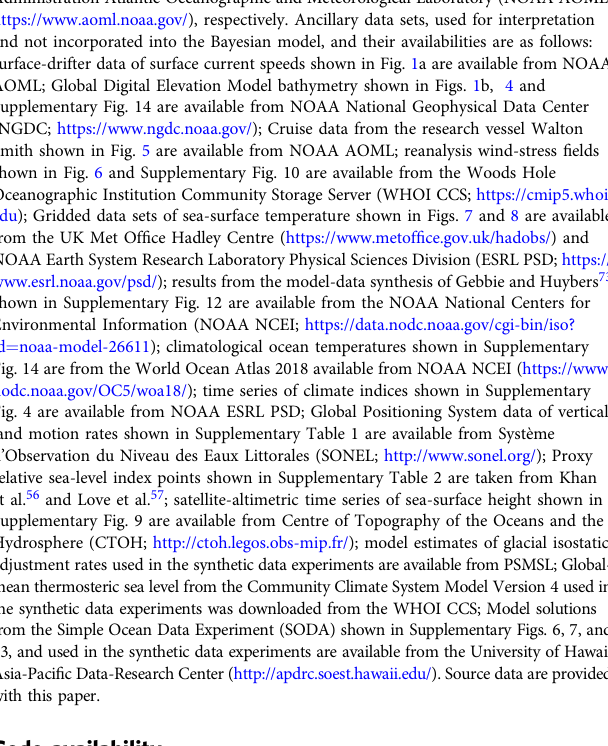
Supplementary Fig. 9 are available from Centre of Topography of the Oceans and the Hydrosphere (CTOH; http://ctoh.legos.obs-mip.fr/); model estimates of glacial isostatic adjustment rates used in the synthetic data experiments are available from PSMSL; Global- mean thermosteric sea level from the Community Climate System Model Version 4 used in the synthetic data experiments was downloaded from the WHOI CCS; Model solutions from the Simple Ocean Data Experiment (SODA) shown in Supplementary Figs. 6, 7, and 23, and used in the synthetic data experiments are available from the University of Hawaii Asia-Paci fi c Data-Research Center (http://apdrc.soest.hawaii.edu/).Source data are provided with this